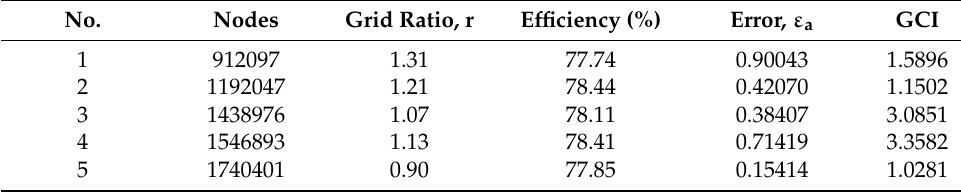
Table 4. Grid convergence uncertainties in the numerical solutions.